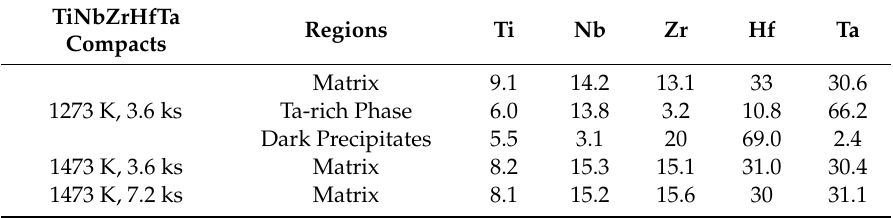
Figure 8. ( a ) TEM image (magnified image of the marked fine precipitate is shown in inset), and ( b ) selected area diffraction (SAD) image (at the matrix) of the TiNbZrHfTa alloy prepared at 1473 K for 3.6 ks. To achieve a homogeneous microstructure, the BCC stabilized compact of TiNbZrHfTa RHEA, sintered at 1473 K (3.6 ks), was heat-treated in an ultra-high vacuum furnace (UlVAC MILA 5000). The heat treatment was carried out at different temperatures and times, i.e., 1273 K for 86.4 ks (Figure 9a), 1473 K for 86.4 ks (Figure 9b), and 1623 K for 0.6 ks (Figure 9c). Despite the heat treatments at higher temperatures for a prolonged time, element segregation was noted in the matrix. The elemental segregation during heat treatment is consistent with the results obtained during prolonged sintering (Figure 7c) wherein fine precipitates of Hf-Zr rich areas were noticed. The chemical analysis data are provided separately in the supplementary file (Figure S1 (Supplementary Materials)). These results are not consistent with the equiatomic TiNbZrHfTa RHEA fabricated by ingot metallurgy wherein phase decompositions are usually reported during annealing below 1273 K and at a temperature above 1273 K, a single bcc phase is usually observed [12,20,31–33]. The chemical composition and presence of fine elements may have a significant influence on the phase stability during heat treatments of the TiNbZrHfTa compact prepared by the powder metallurgy process; however, this is a task for further investigations.